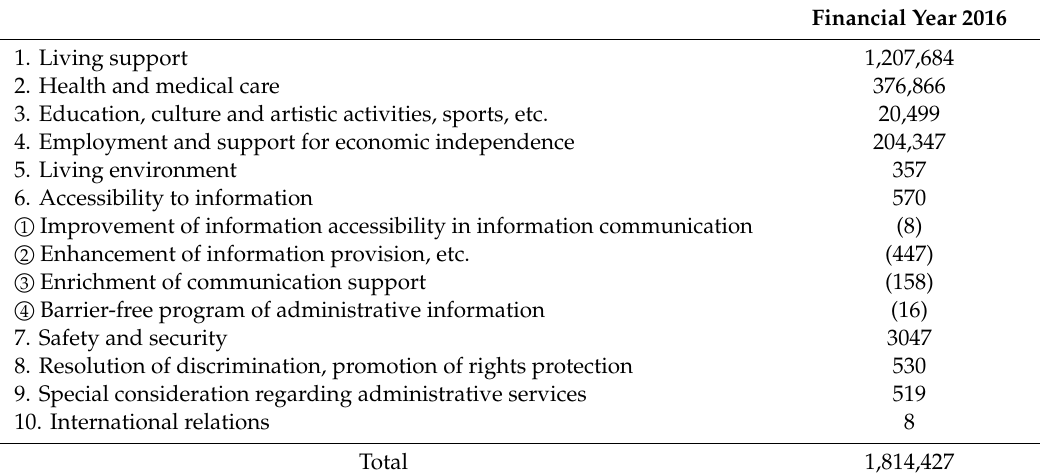
Table 1. Outline of the FY2016 budget for people with disabilities. Unit: ¥1